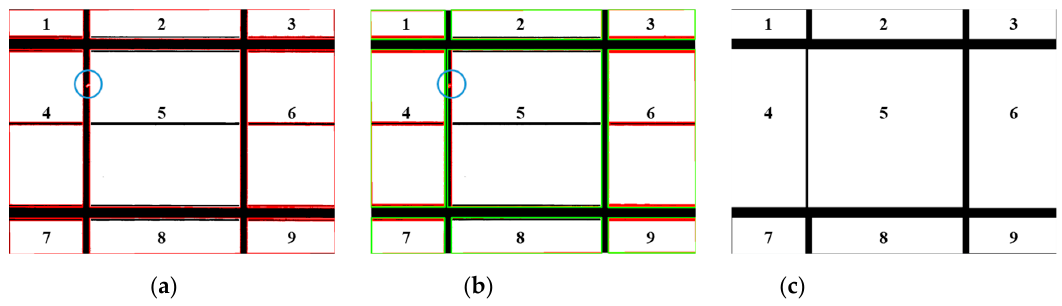
Figure 7. ( a ) The red lines and curves are the boundaries of the connected blocks, and a defect is marked with a blue circle; ( b ) the green boxes are the bounding boxes of the connected blocks; ( c ) The mask obtained by the bounding boxes in ( b ) is affected by the defect circled in ( a , b ). As explained previously, the spacing between the blocks in each image is the same. After measuring the pixel distance of the image spacing, we found that x d 1 = x d 2 = 85 pixels and y d 1 = y d 2 = 135 pixels, as shown in Figure 6b. From the correct bounding boxes and the fixed block spacing, the blocks and intervals can be correctly